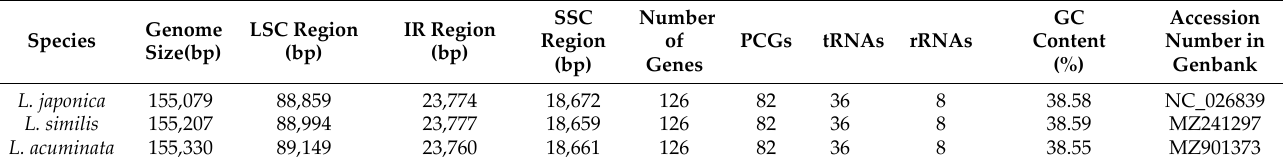
Figure 1. Gene maps of the three Lonicera chloroplast genomes. ( A ) L. similis ; ( B ) L. acuminata ; ( C ) L. japonica . Small single copy (SSC), large single copy (LSC), and inverted repeats (IRA, IRB) are indicated. The black of the inner circle indicates GC content, and dark gray indicates AT content. Table 1. Summary of complete cp genomes of three Lonicera